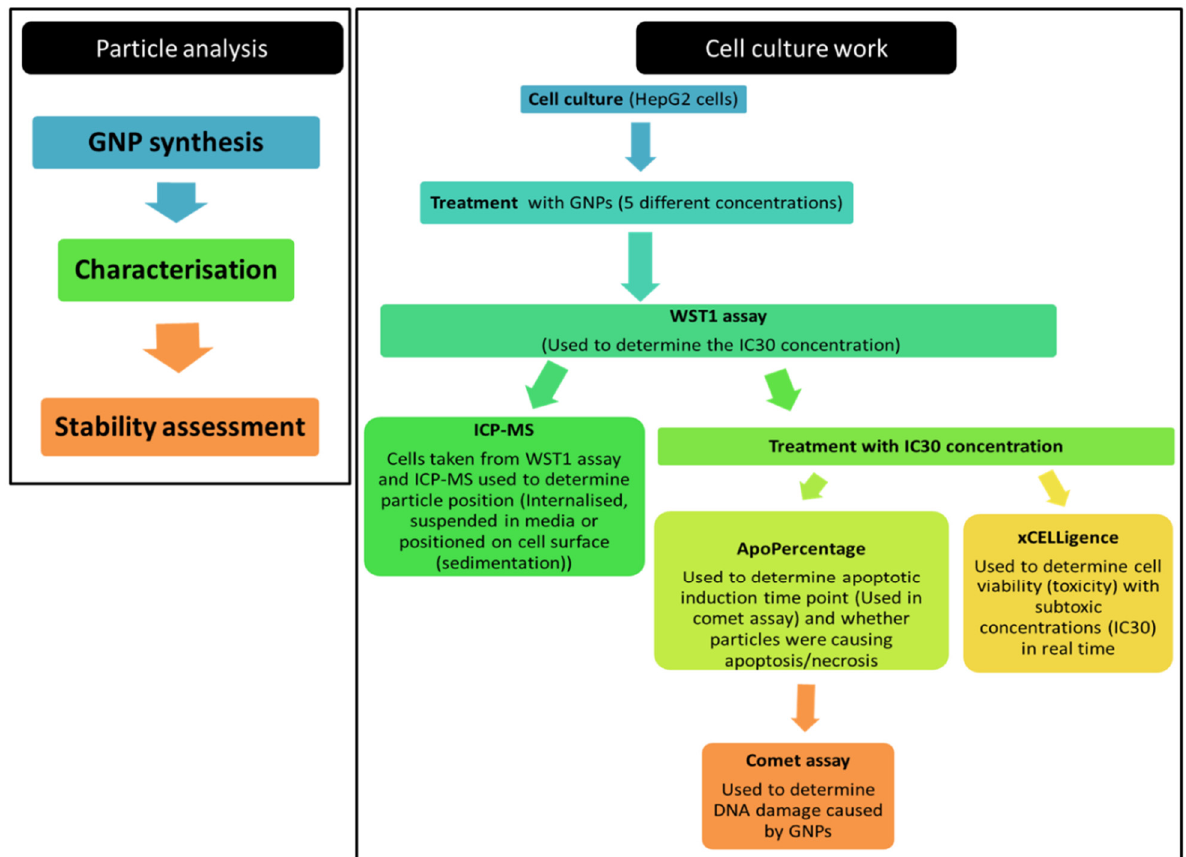
Figure 1. Flow diagram showing the various methods used in this study.